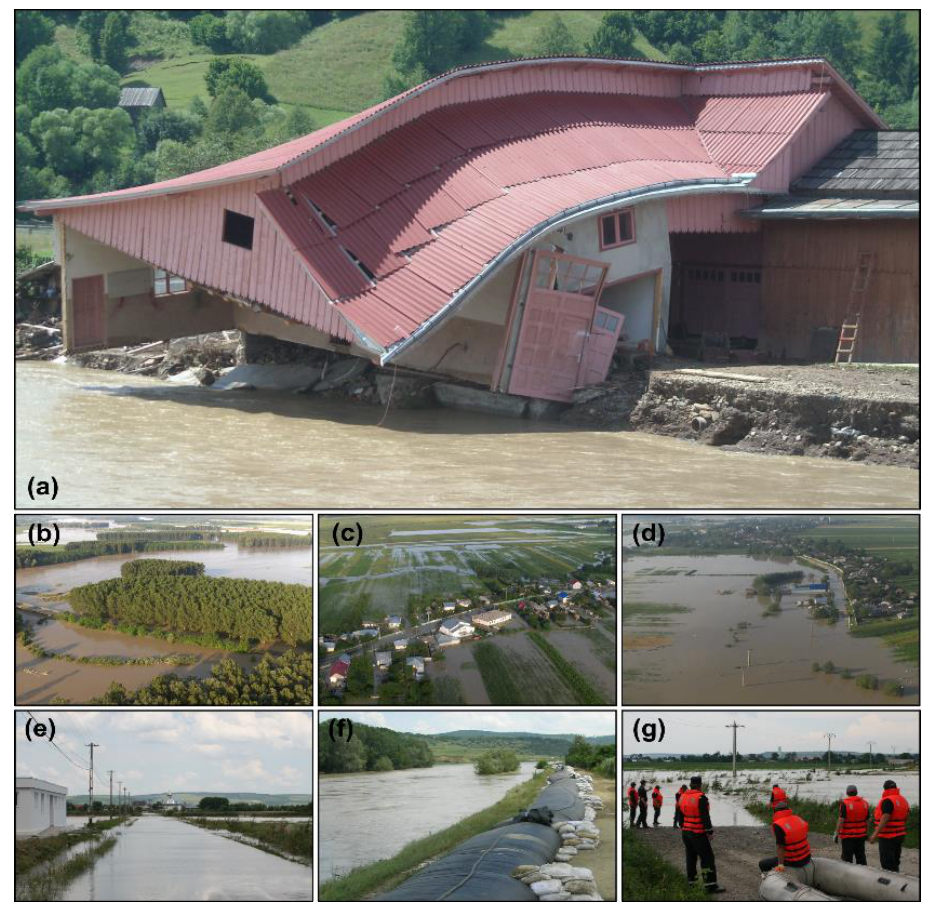
Figure 3. Damage caused by floods within the Siret catchment in the summer of the year 2010: ( a ) houses damaged by the flood on Moldovita, left tributary of the Moldova River (Suceava basin); ( b ) Siret flooded north from the city of Bacau; ( c ) Siret flooded in the Saucesti commune (Bacau County); ( d ) localities, arable land, and infrastructure affected by the floods in the middle sector of the Siret River; ( e ) Roads affected by floods in the lower sector of the Siret River; ( f ) Temporary dams that were resistant to the floods on the Siret River; ( g ) Intervention of employees with the Inspectorate for Emergency Situations, Bacau.